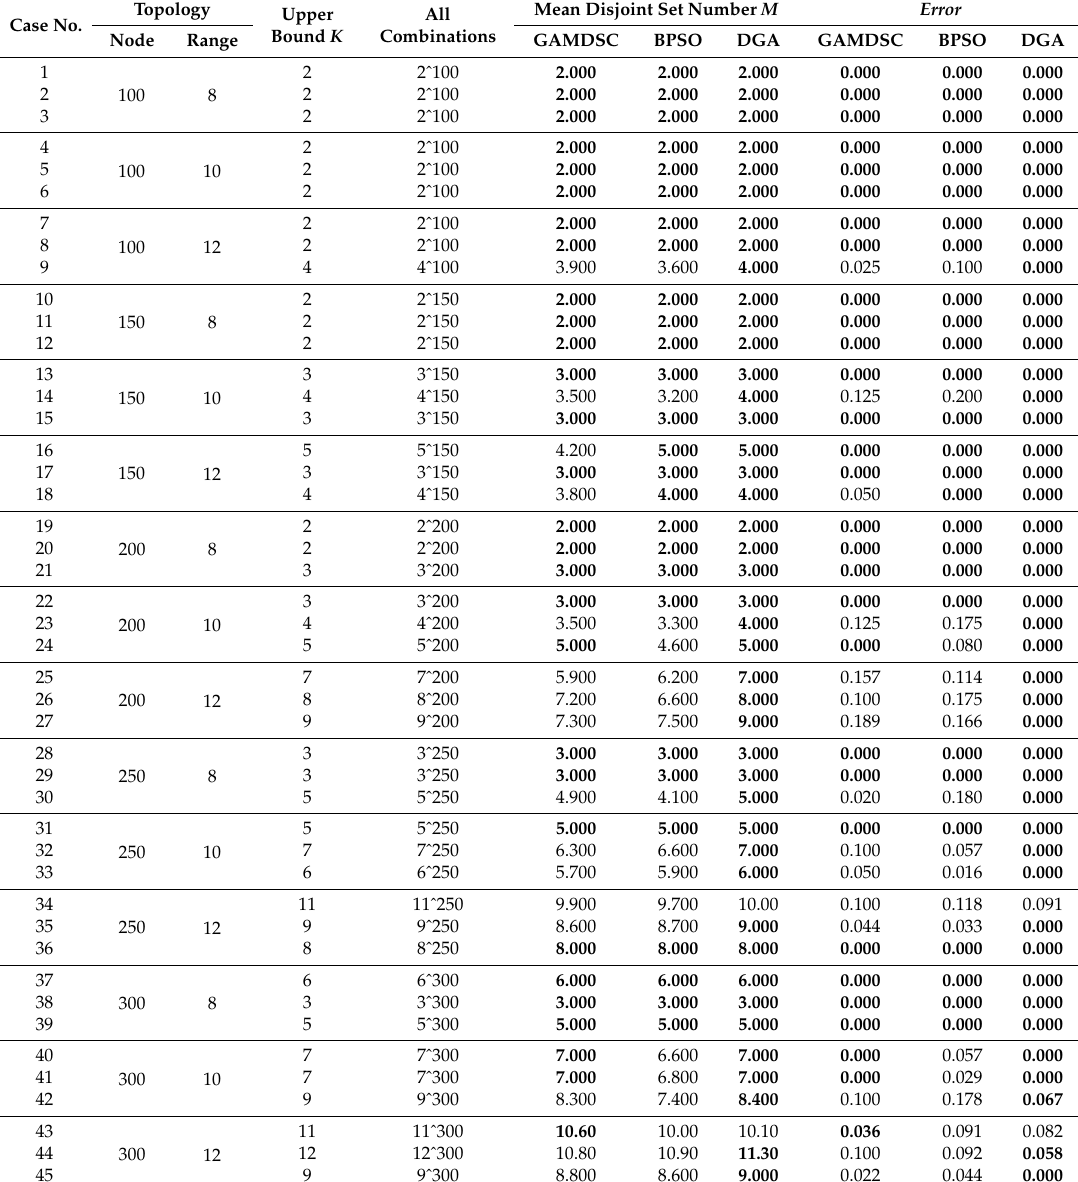
Table 2. Experimental Results of